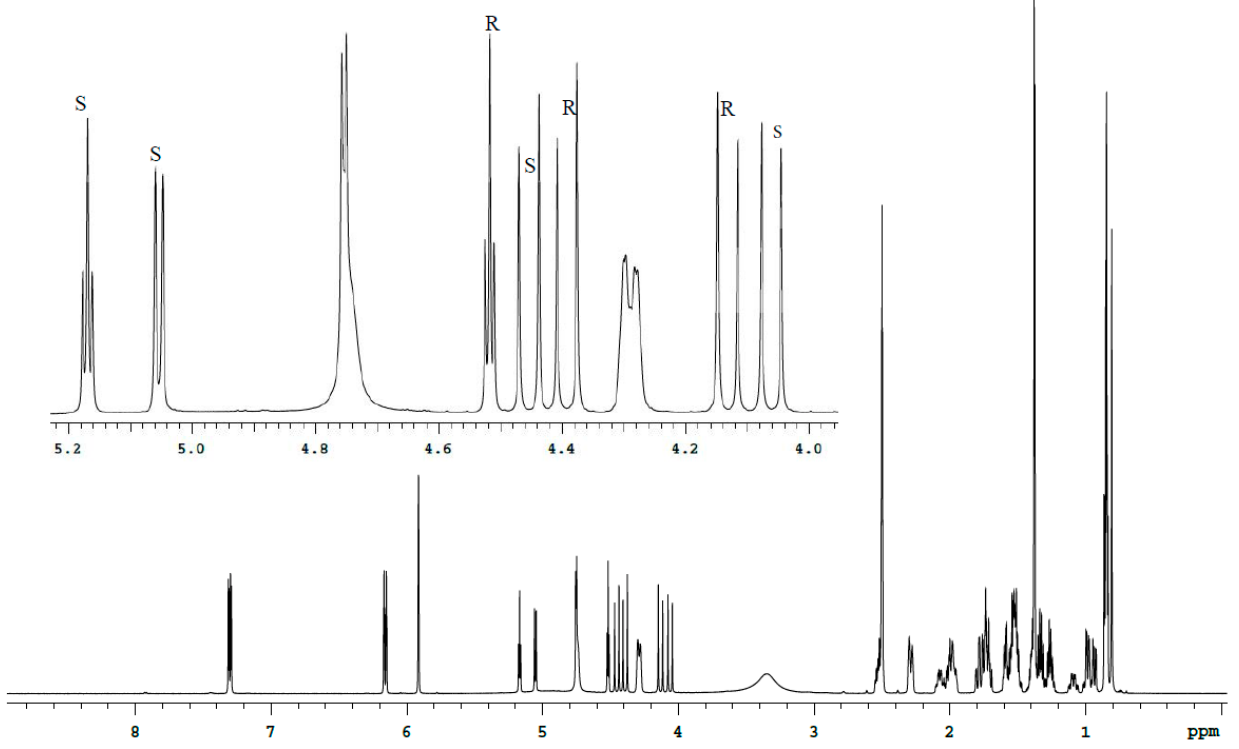
Figure 3. 1 H spectrum of the Bud-API solution in Figure 3. 1 Н spectrum of the Bud-API solution in DMSO-d6.